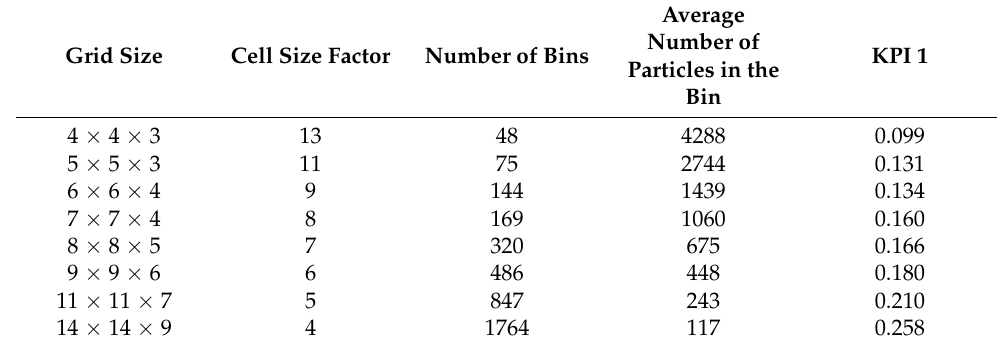
Table 4. Influence of grid system on KPI 1 for run